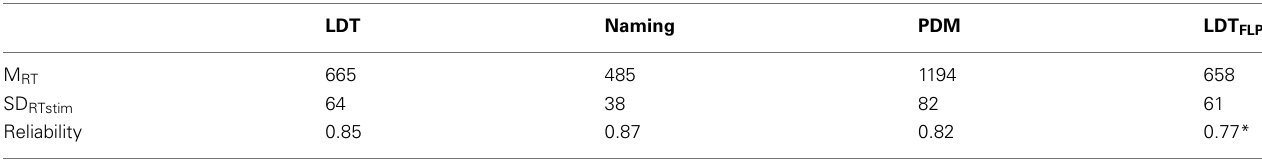
Table 2 | Mean reaction times and SD across stimuli for the three Chronolex tasks and the words present in FLP ( N = 1,482 for Chronolex and 1,416 for FLP).